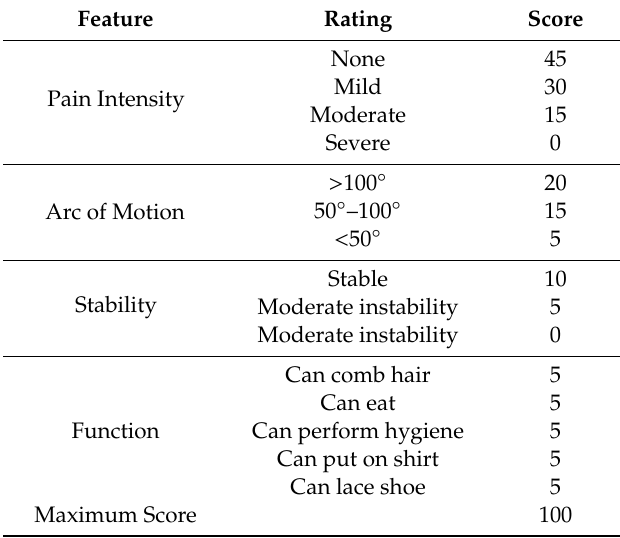
Table 3. Mayo Elbow Performance